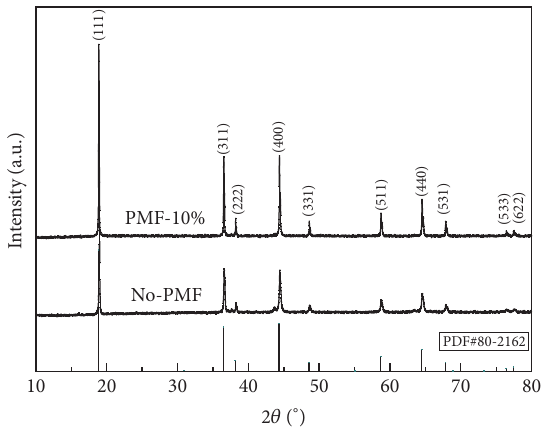
Figure 1: XRD patterns of prepared LiNi 0.5 Mn 1.5 O 4